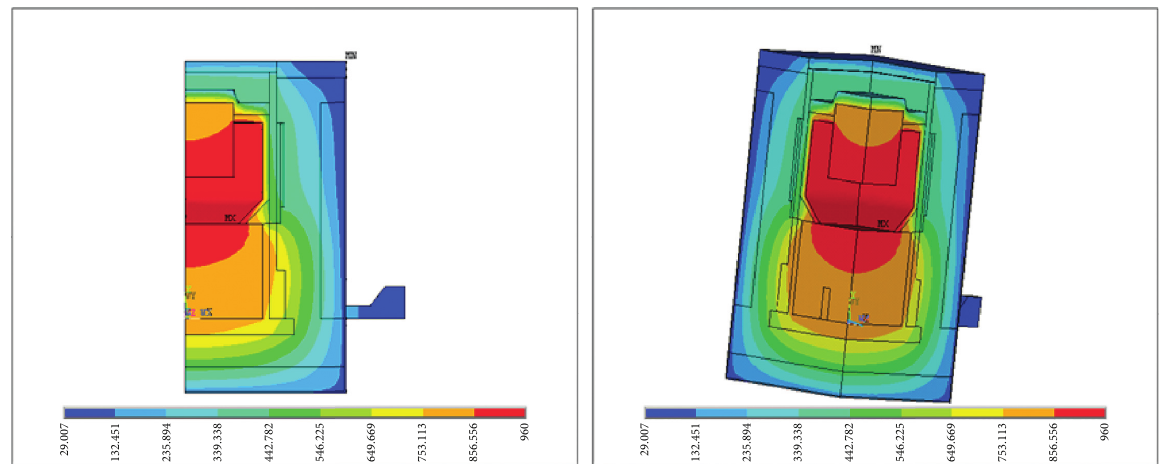
Figure 6: ANSYS simulation results of the temperature gradients in the 2kA laboratory heat-exchanging